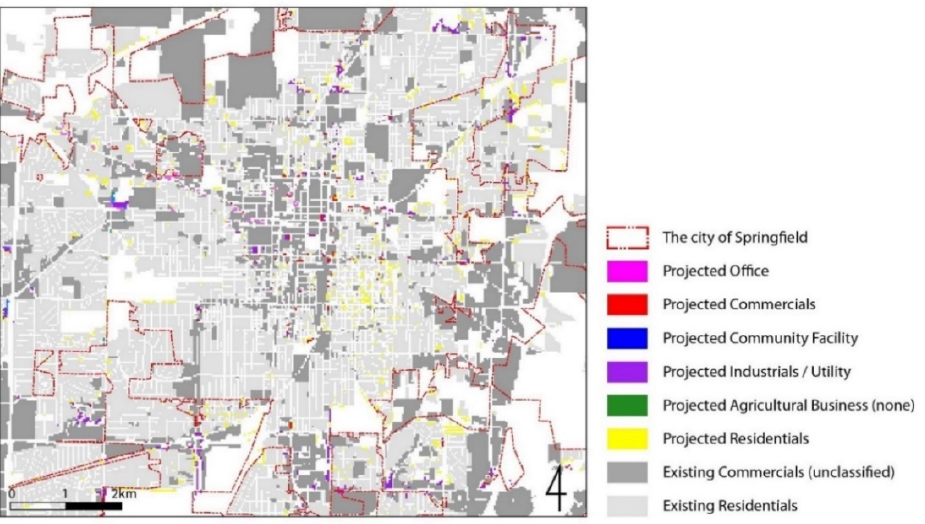
Figure 9. Land-use change projection with sectoral classifications. It shows the projected spatial locations of future development. Office and commercial land-uses are expected to be agglomerated at the urban center.